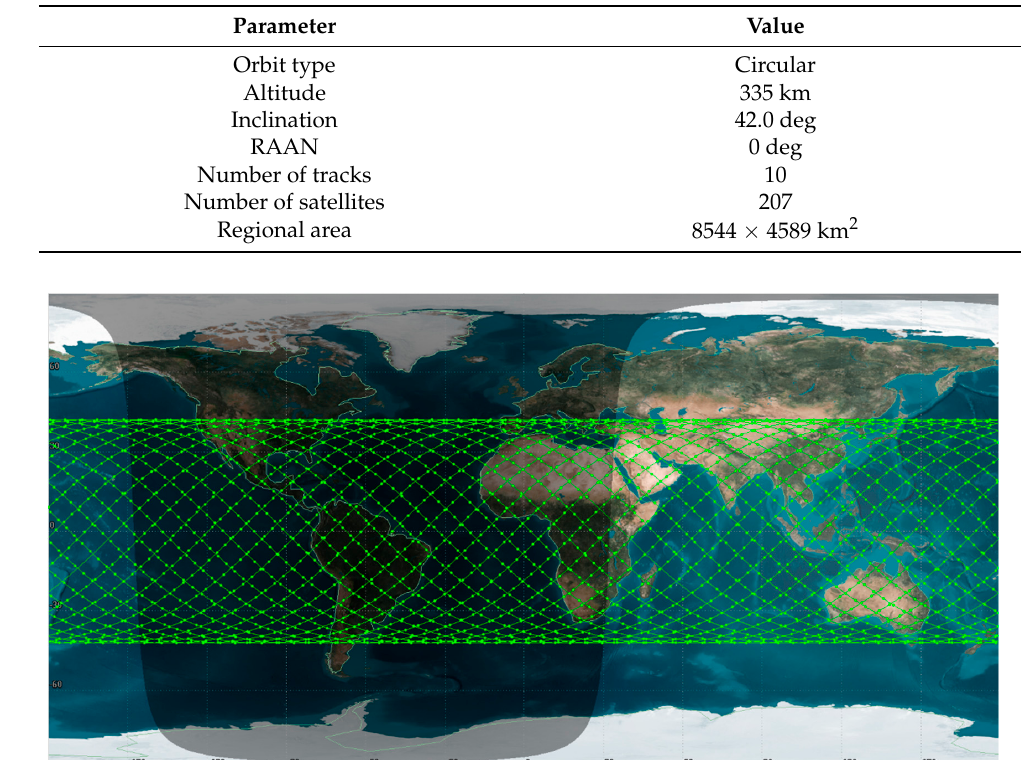
Table 1. Orbit parameter information.